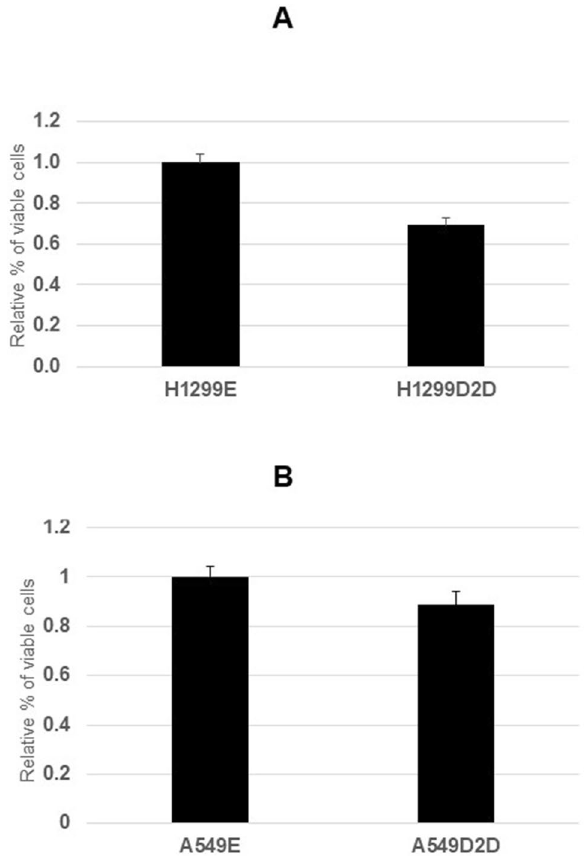
Figure 6. Cell viability of the FANCD2 knockdown lung cancer A549D2D and H1299D2D cells. Cells were cultured in RPMI 1640 medium with 10% fetal bovine serum and 1% penicillin/streptomycin in a humidified incubator (37 °C, 5% of CO 2 ) for 48 h. Each cell line was repeated in quadruplicate. Absorbance at 570 nm wavelength was recorded using a micro plate reader. An averaged absorbance of blank values (containing all reagents except cells) was subtracted from all absorbance to yield corrected absorbance. The relative absorbance of each FANCD2 knockdown cell was calculated by comparing the average of corrected absorbance with an average of corrected absorbance of control cell. Each value presented in this figure was an average value obtained from 4 measurements. The error bars show standard deviation. ( A ) H1299D2D /H1299E, ( B )